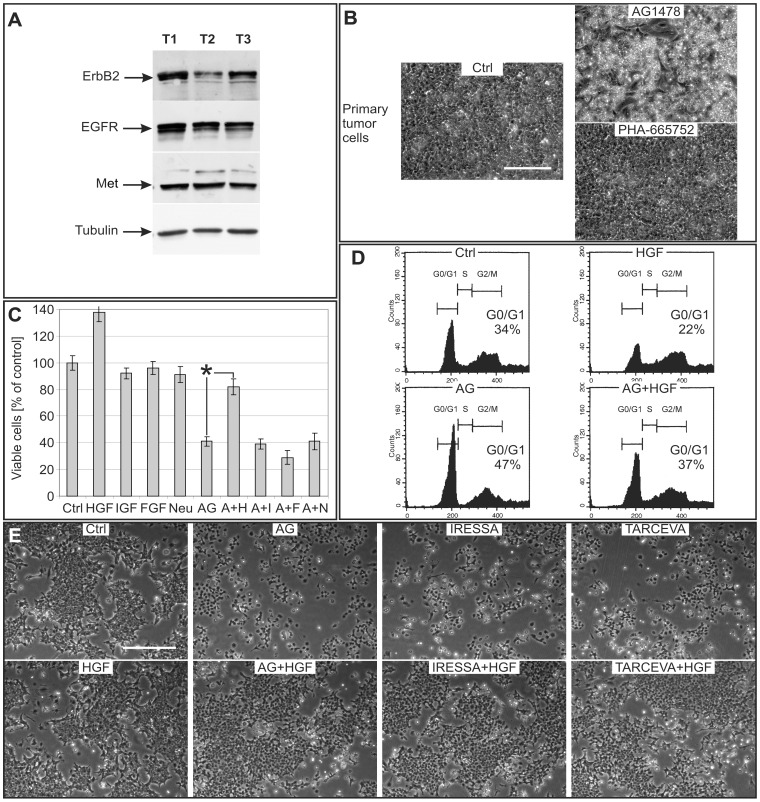
HGF is a survival factor of EGFR inhibited ErbB2 mammary tumor cells. A.Western-blot analysis of ErbB2, EGFR and Met expression in mammary tumors obtained from three separate transgenic ErbB2 mutated mice (see materials and methods). Tubulin was used as an internal loading control. B. Phase contrast images of primary cells from ErbB2 mammary tumors (bar  = 500 µm). Cells were grown in proliferation medium and either left untreated (Ctrl) or treated with AG1478 (250 nM) or PHA-665752 (250 nM) for 96 h. C. Viable cell count by trypan-blue exclusion staining at 48 h, of immortalized ErbB2 tumor cells treated with the indicated factors (HGF 10 ng/ml (H), IGF-I 100 ng/ml (I), b-FGF 20 ng/ml (F), Neuregulin 20 ng/ml (N); AG1478 250 nM (A)). Untreated control (Ctrl) was set to 100%. Columns, mean (n = 6); bars, S.E.M. *P<0.05. D. Cell cycle distribution examined by propidium iodide staining and FACS analysis of ErbB2 mammary tumor cells cultivated in growth medium and treated with the indicated factors for 16 h (HGF 10 ng/ml, AG1478 250 nM). E. Immortalized ErbB2 tumor cells cultivated in their respective growth medium for 48 h with the indicated factors (HGF 10 ng/ml; AG1478 250 nM; IRESSA 1 µM; TARCEVA 1 µM). Bar  = 500 µm.